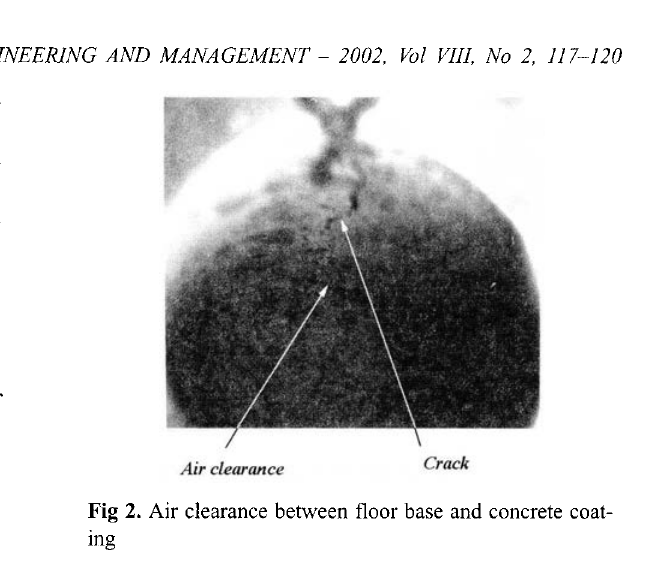
Fig 2. Air clearance between floor base and concrete coat- ing